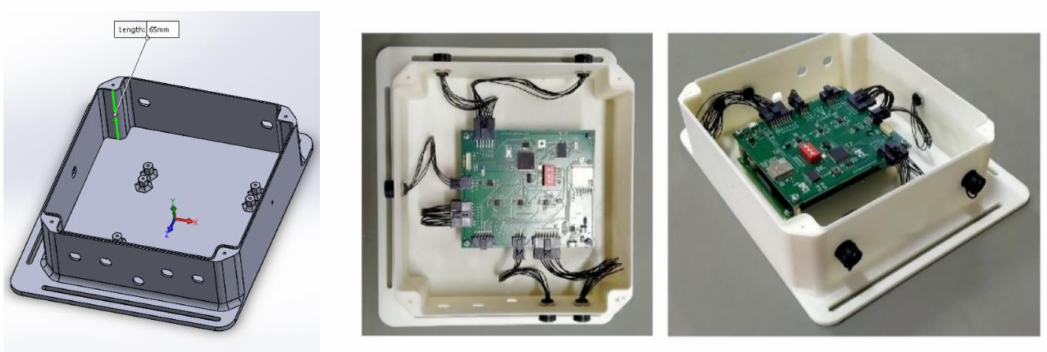
Figure 7. Three-dimensional model and dimensions ( left ); assembly process photos of box 1 ( middle and right ).